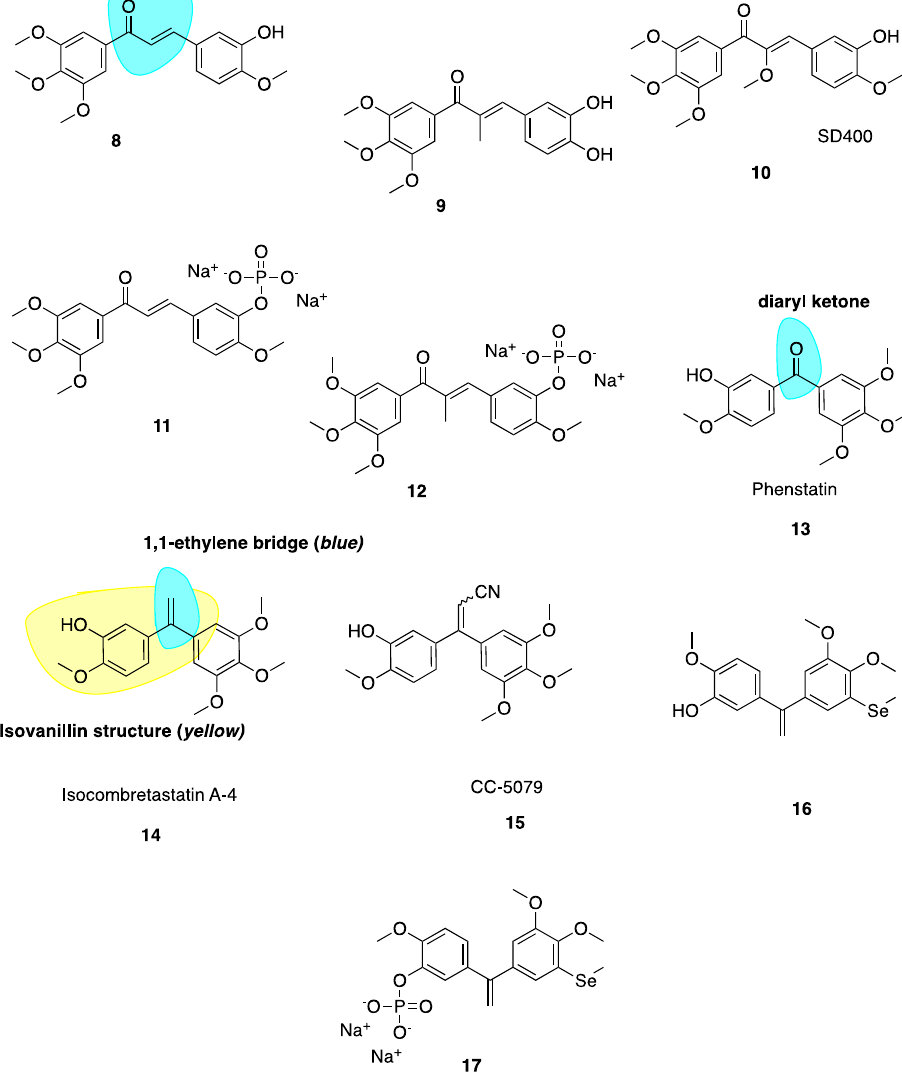
Figure 4. Combretastatin A-4 analogues 8 – 17 .